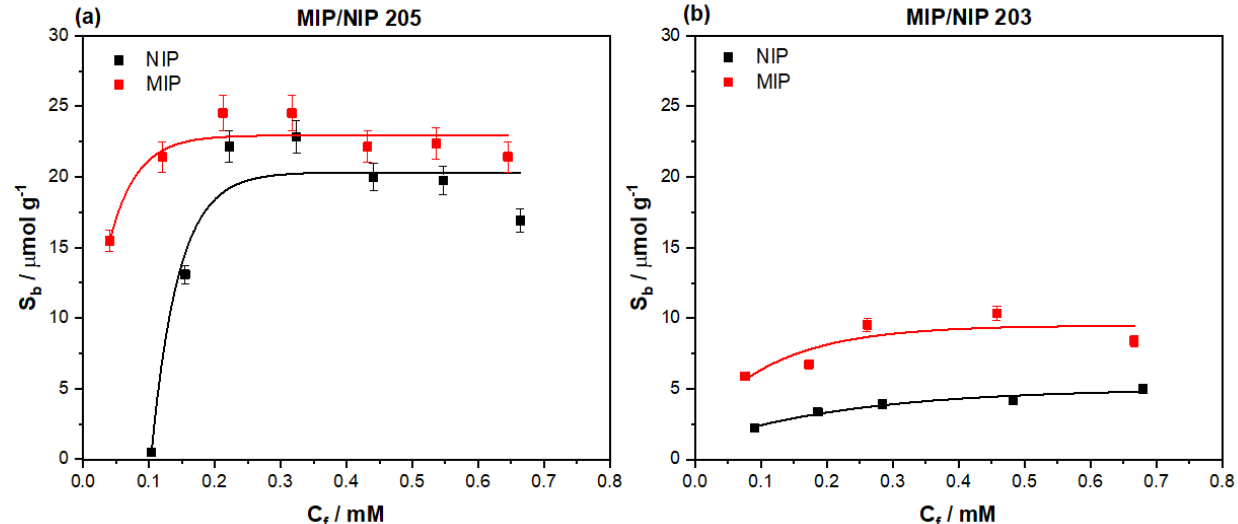
Figure 8. Binding isotherms for ( a ) MIP 205 prepared by emulsion polymerization and ( b ) a rescaled MIP 203 prepared by bulk polymerization strategies, where both MIP (red squares) and NIP (black squares) were plotted and fit. Table 3. Binding capacities (S b ) for MIP 203 (amoxicillin, ampicillin, and cloxacillin) and MIP 205 at C f = 0.1 and their corresponding imprint factors (IF). Values were drawn directly from the fitted curve of each MIP/NIP at the defined